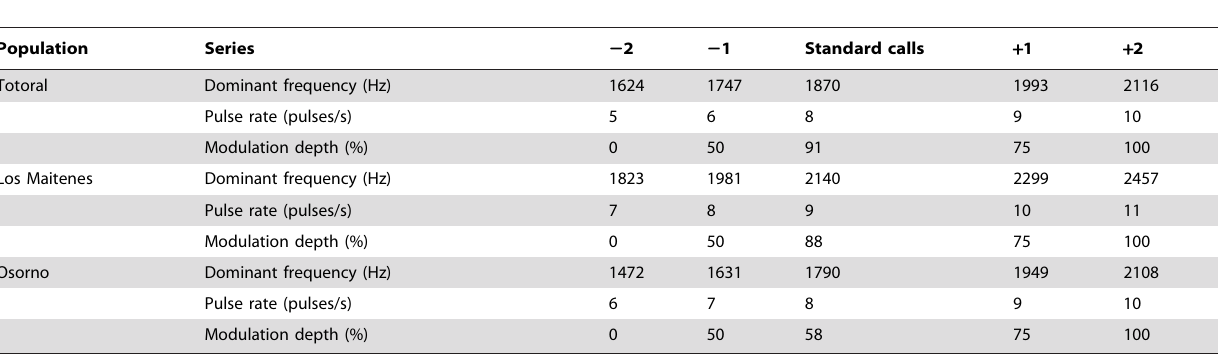
Table 2. Acoustic parameters of the calls of the Dominant frequency, Pulse rate and Modulation depth series for three populations of Pleurodema thaul .